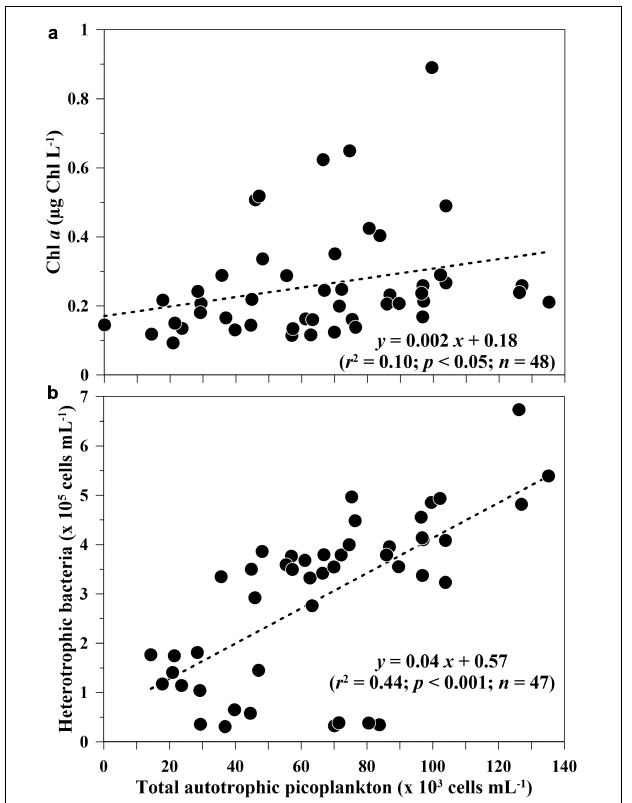
FIGURE 6 | Relationships between the depth-integrated values of total autotrophic picoplankton abundance ( × 10 3 cells mL − 1 ) versus (a) chlorophyll a value (Chl a ; µ g Chl L − 1 ) and (b) heterotrophic bacteria abundance ( × 10 5 cells mL − 1 ) for the upper 100 m depth of all sampling stations.